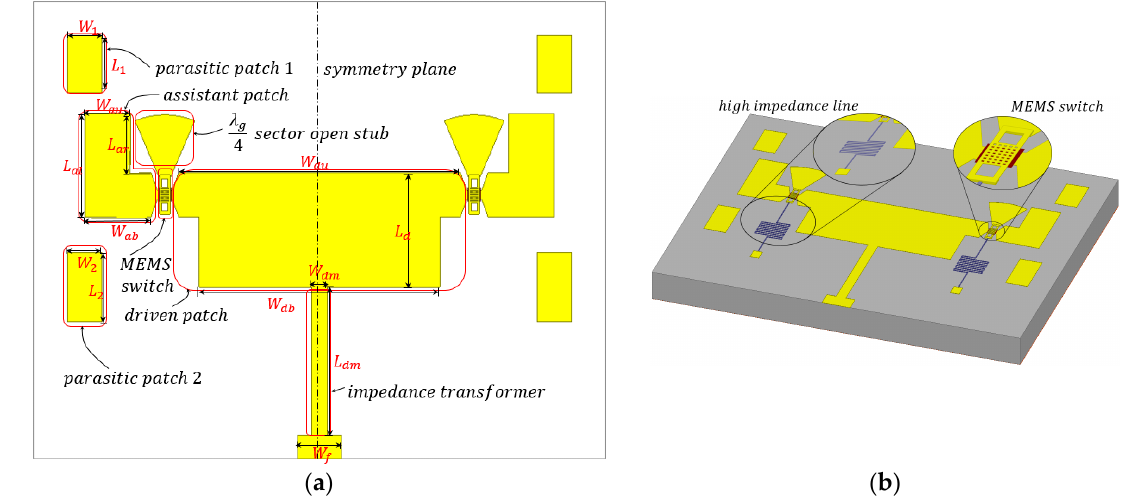
Figure 1. Proposed pattern reconfigurable antenna. ( a ) The configuration of proposed antenna. ( b ) The 3D view of the proposed antenna.